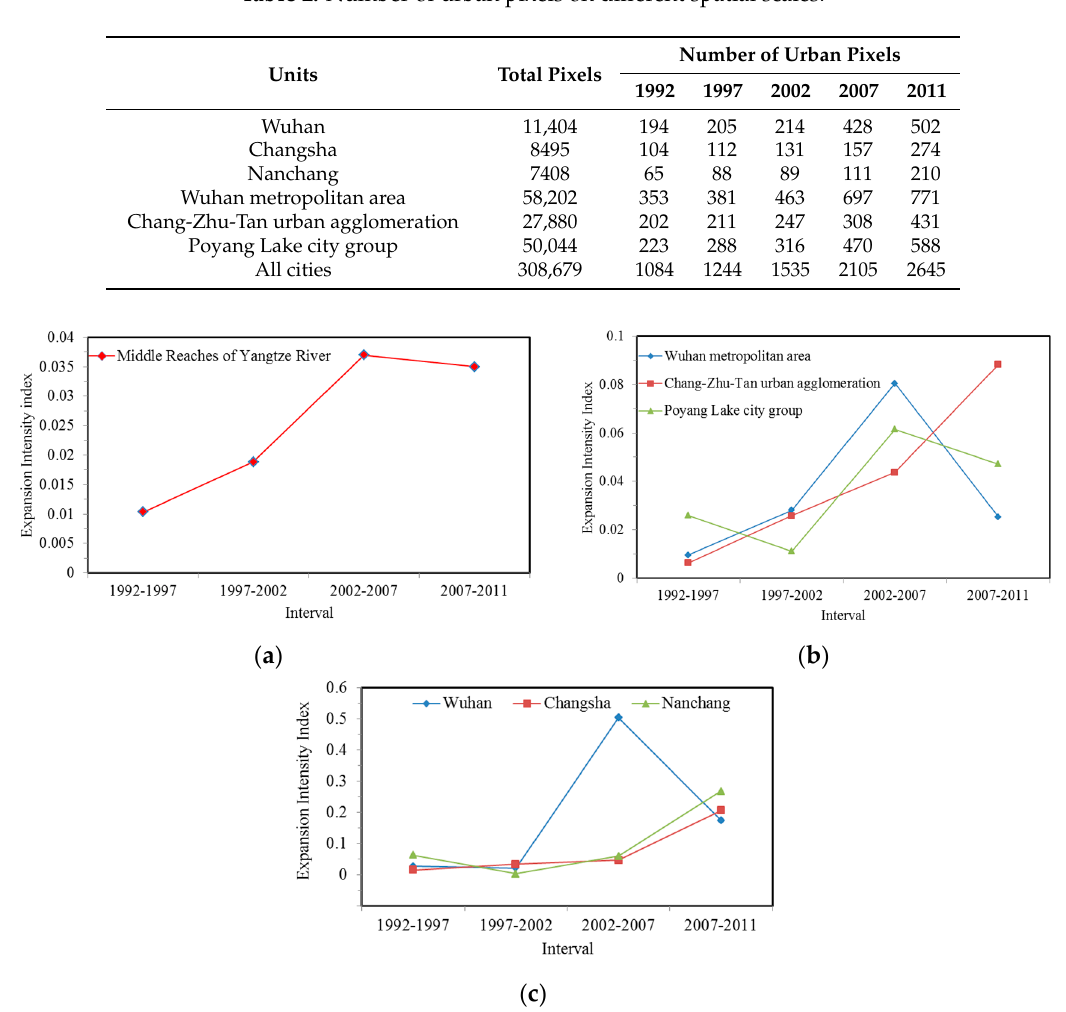
Table 2. Number of urban pixels on different spatial scales.